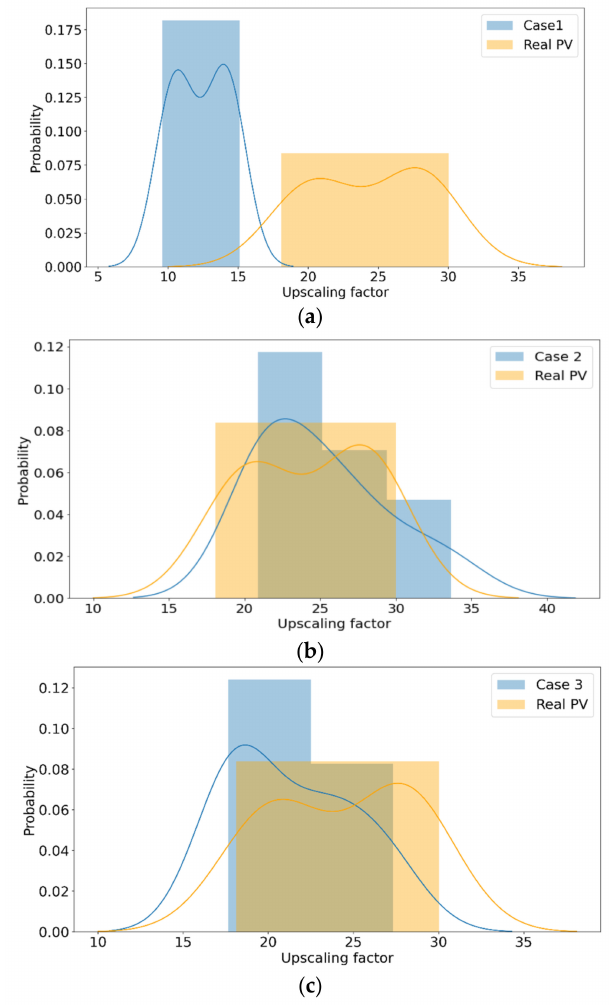
Figure 12. Comparison of upscaling factor distribution ( a ) Case 1 ( b ) Case 2 ( c ) Case